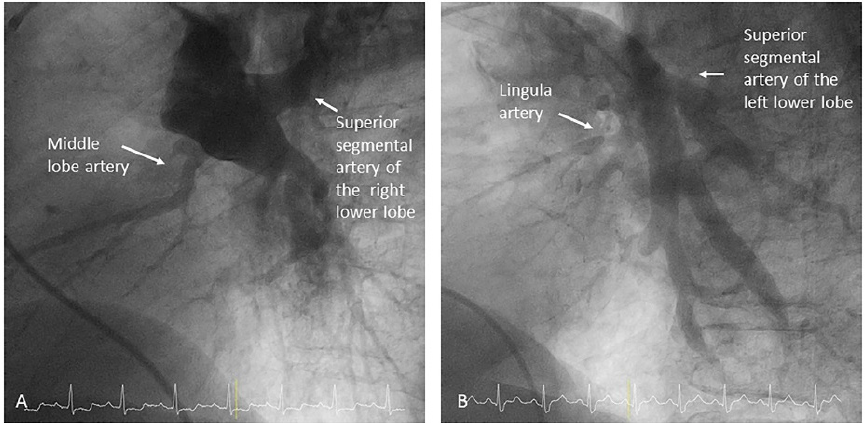
Figure 14. Lower lobes superior segmental arteries (A6), opposite to ( A ) the middle lobe and ( B ) lingula arteries. (( A , B ): lateral view).